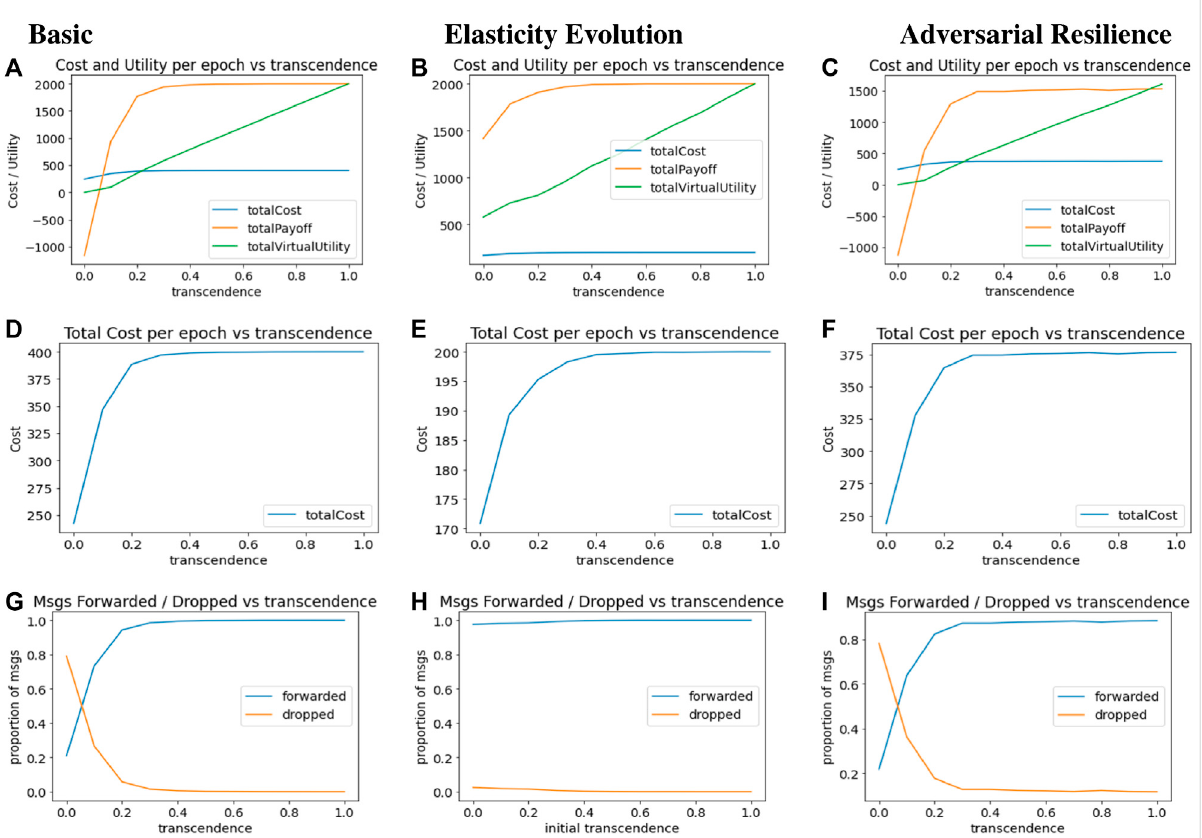
FIGURE 5 Result Plots for Computational Transcendence in Basic, Evolutionary and Adversarial Networks (A) Basic: Total Metrics (B) Evolutionary: Total Metrics (C) Adversarial: Total Metrics (D) Basic: Cost perepoch (E) Evolutionary:Cost perepoch (F) Adversarial: Costper epoch (G) Basic: Forwarded Ratio (H) Evolutionary: Forwarded Ratio (I) Adversarial: Forwarded